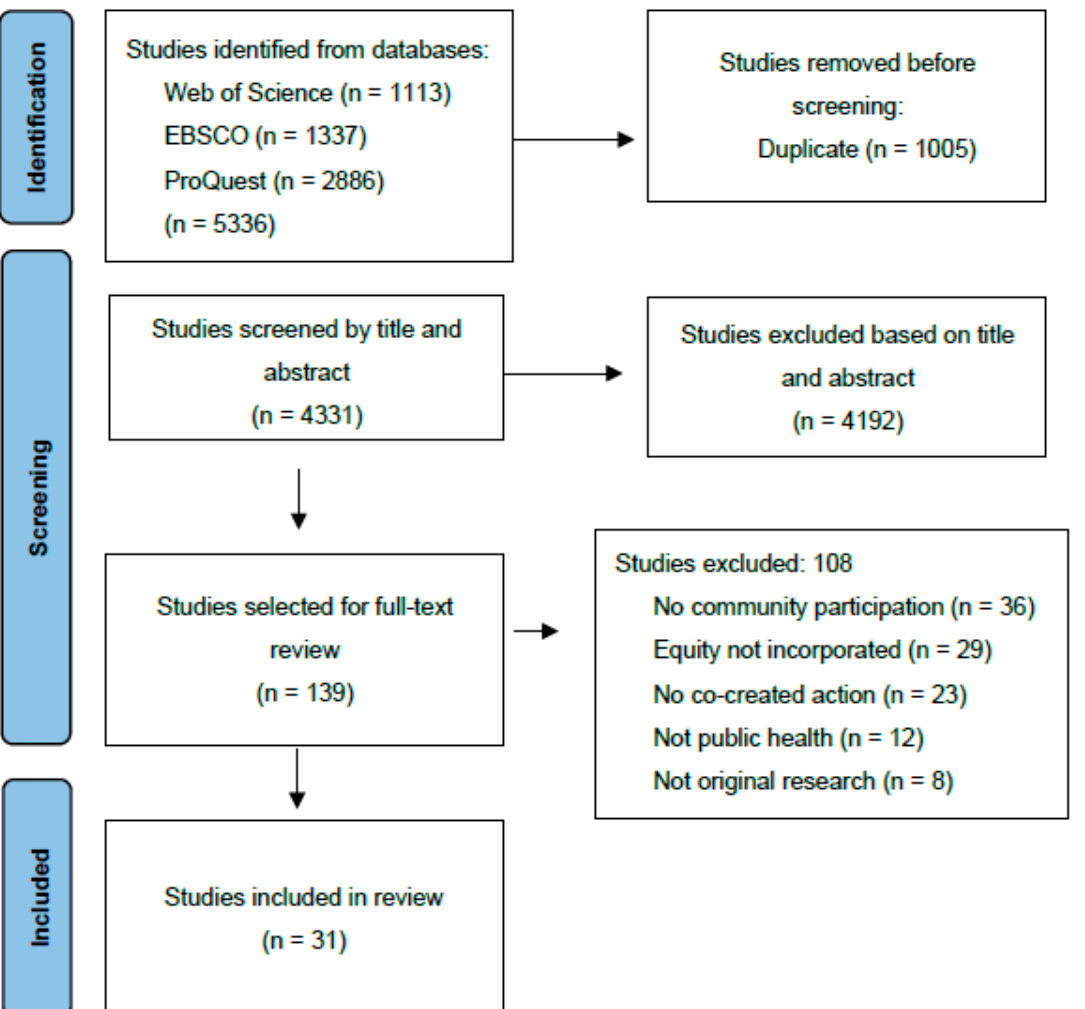
Figure 1. Flow diagram of search and selection .